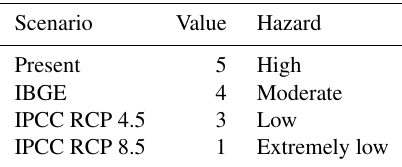
Table 1. Attributed value to hazard map. Table 2. Attributed value to vulnerability map.